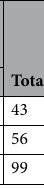
Table 2. 2 × 2 contingency table for cancer presence at margins detected by specimen